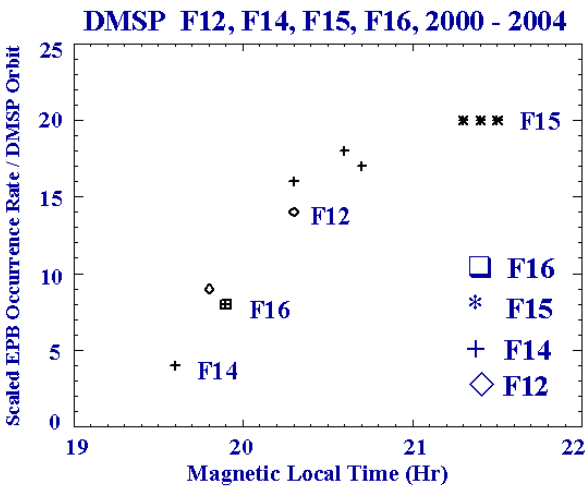
Fig. 10. LT distribution of EPBs observed from DMSP F12, F14, F15, and F16 at 848-km altitude for 2000 to 2004 as a function of LT. Non-solar maximum years 2002–2004 were scaled to solar maximum years